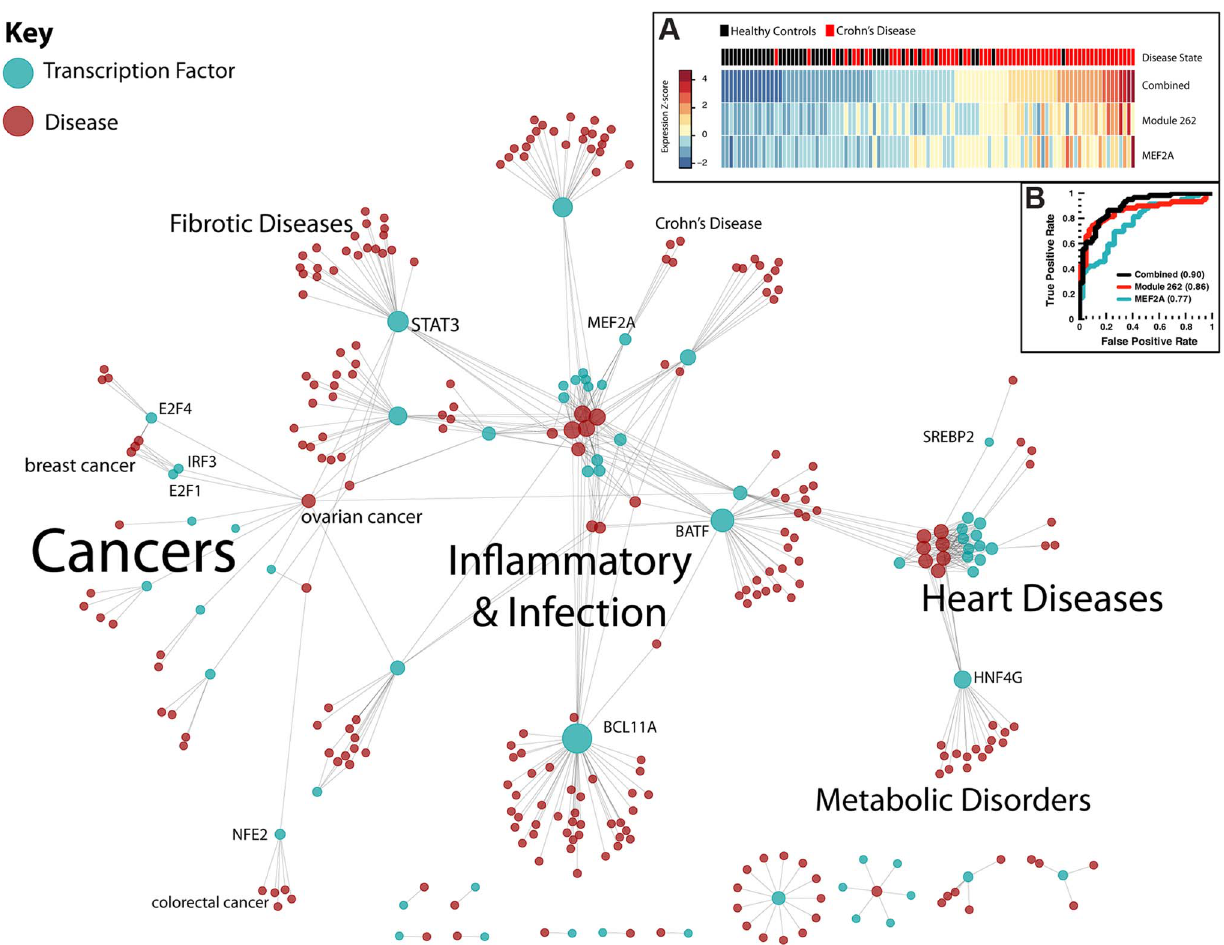
Figure 5. Regulatory network of human disease. Transcription factors (blue) are connected to diseases (red) through modules in this bipartite graph. Prominent clusters of diseases are highlighted, as well as some highly-connected transcription factors. Importantly, STAT3 is connected to many fibrotic diseases, while E2F1 and E2F4 are connected to breast and ovarian cancer. (A): Expression of MEF2A and the projection of module 262 are significantly predictive of disease state. Individuals are ranked by their combined score (sum of normalized expression and module projection). (B): ROC curve for prediction of Crohn’s disease from MEF2A expression, module 262 projection, and combined metric.